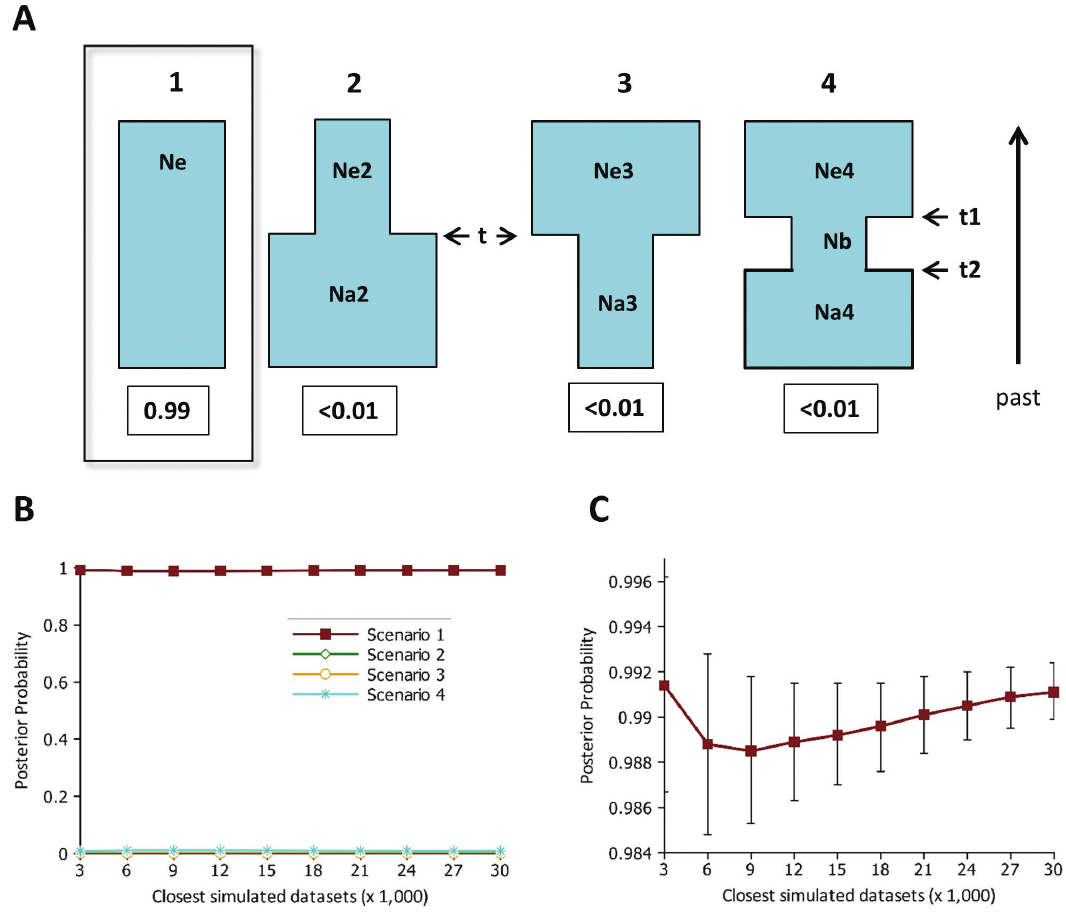
Figure 2 - Demographic scenarios for humpback whales from BSA. (a) The four demographic scenarios tested with the DIYABC approach: 1 - constant population, 2 - bottlenecked population, 3 - expanded population, 4 - population with a transitory bottleneck. Demographic parameters: N e - long-term; N e 2, N e 3 and N e 4 - current; N a 2 and N a 4 - pre-bottleneck; N a 3 and N b - during bottleneck. The posterior probability of each scenario is given at the bottom. (b) Posterior probabilities (y-axis) with confidence intervals of the four scenarios in different numbers of selected closest-to-observed simulations based on the direct estimate, and (c) logistic regression (only for scenario